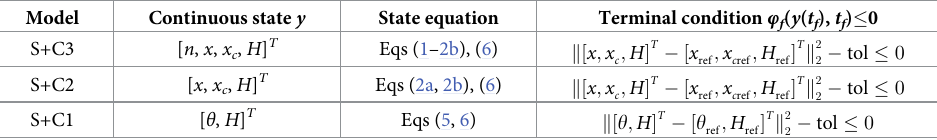
Table 3. Entrainment formulation for two-process